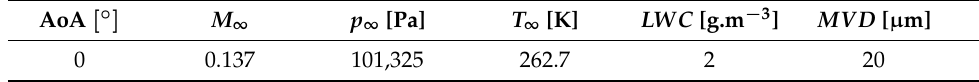
Table 5. Aerodynamic and icing conditions for anti-icing Case 87b